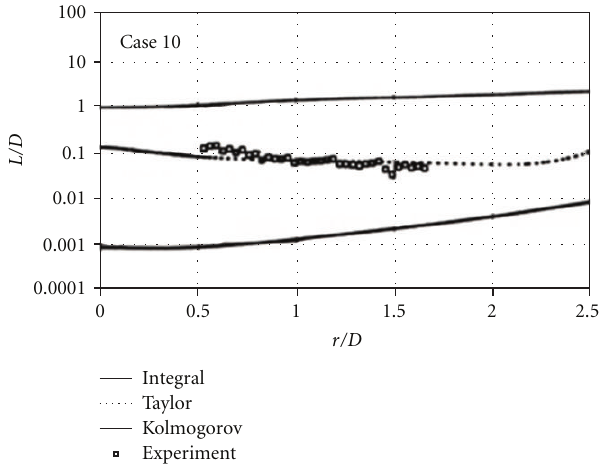
Figure 3: Comparison between calculated and experimental length scales for a single jet of LN 2 injected into GN 2 at x/d = 10, chamber pressure of 6MPa, 1.9 m/s, injected temperature of T = 132K. Branam and Mayer [13].